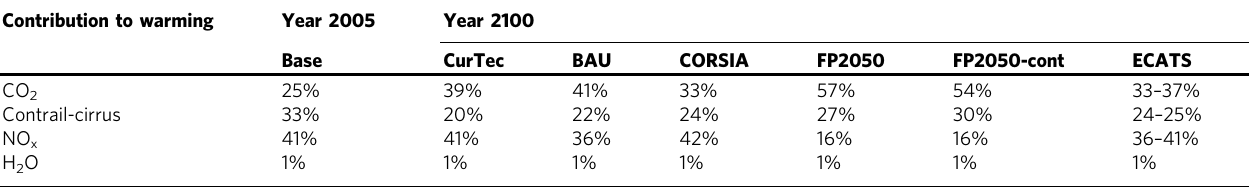
Table 2 Relative contributions of individual climate agents to climate warming (temperature change) in the year 2005 and for the 5 scenarios in 2100.